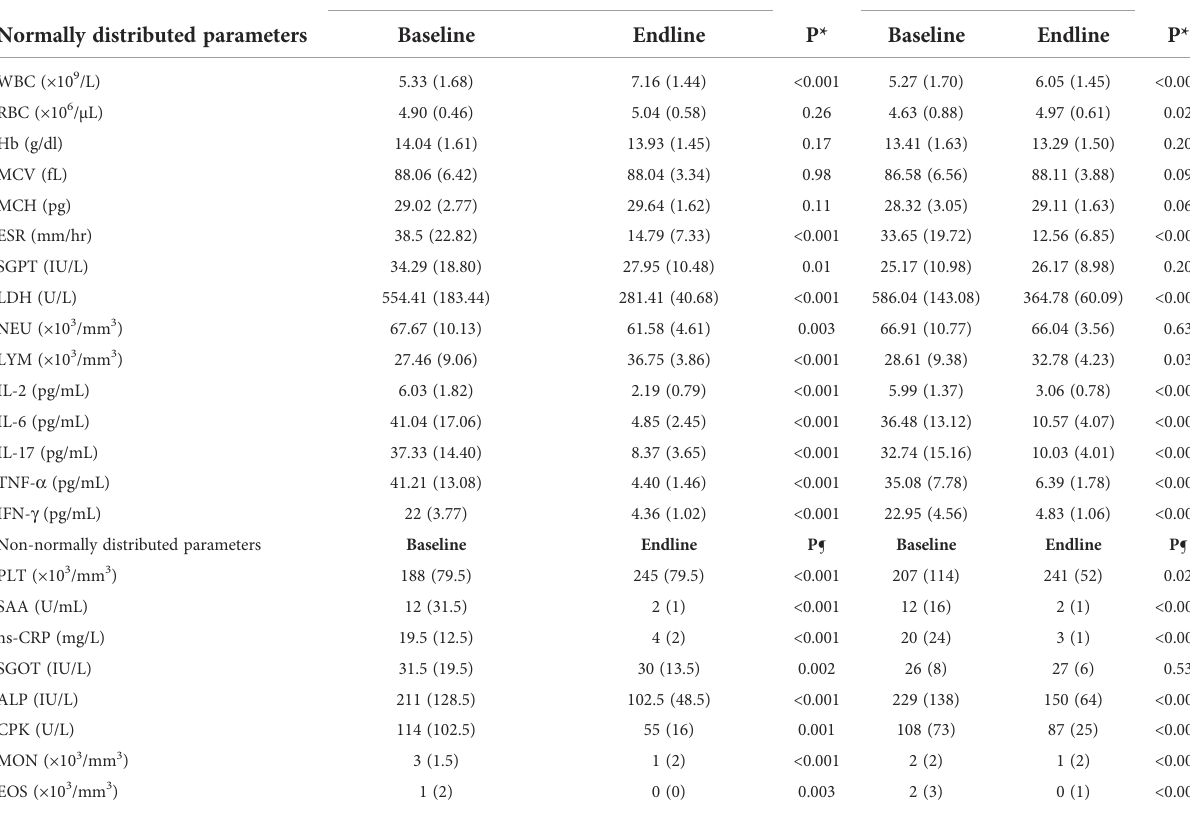
TABLE 2 Level of parameters in baseline and endline within intervention and control